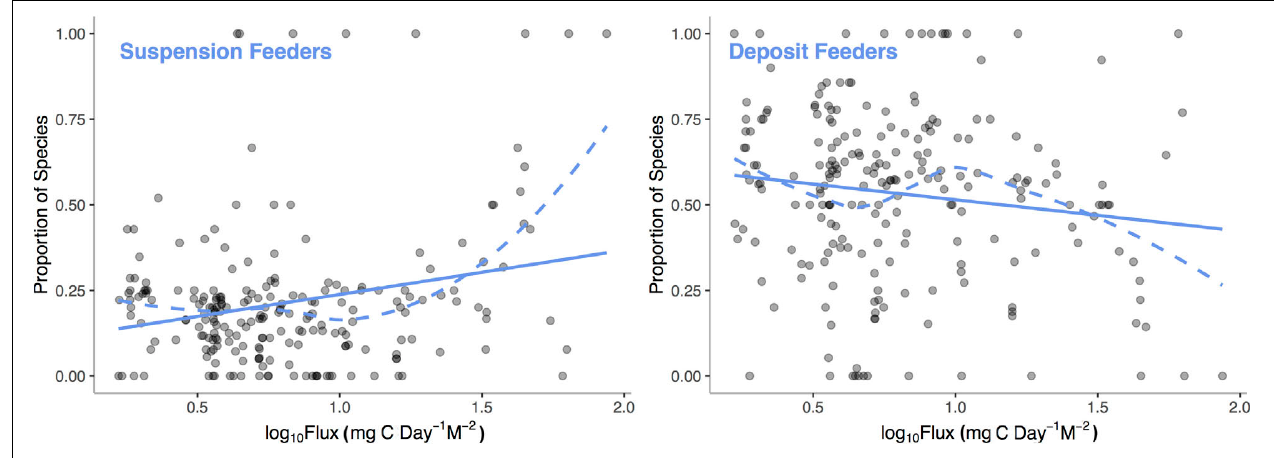
FIGURE 6 | Proportion of deep-sea, bivalve species that are suspension feeders and deposit feeders among sampling stations across the Atlantic Ocean verses Log 10 Standardized Carbon Flux (gC m - 2 d - 1 ) for the sampling station. Dashed line represent LOESS smooths and the solid lines represent general additive model